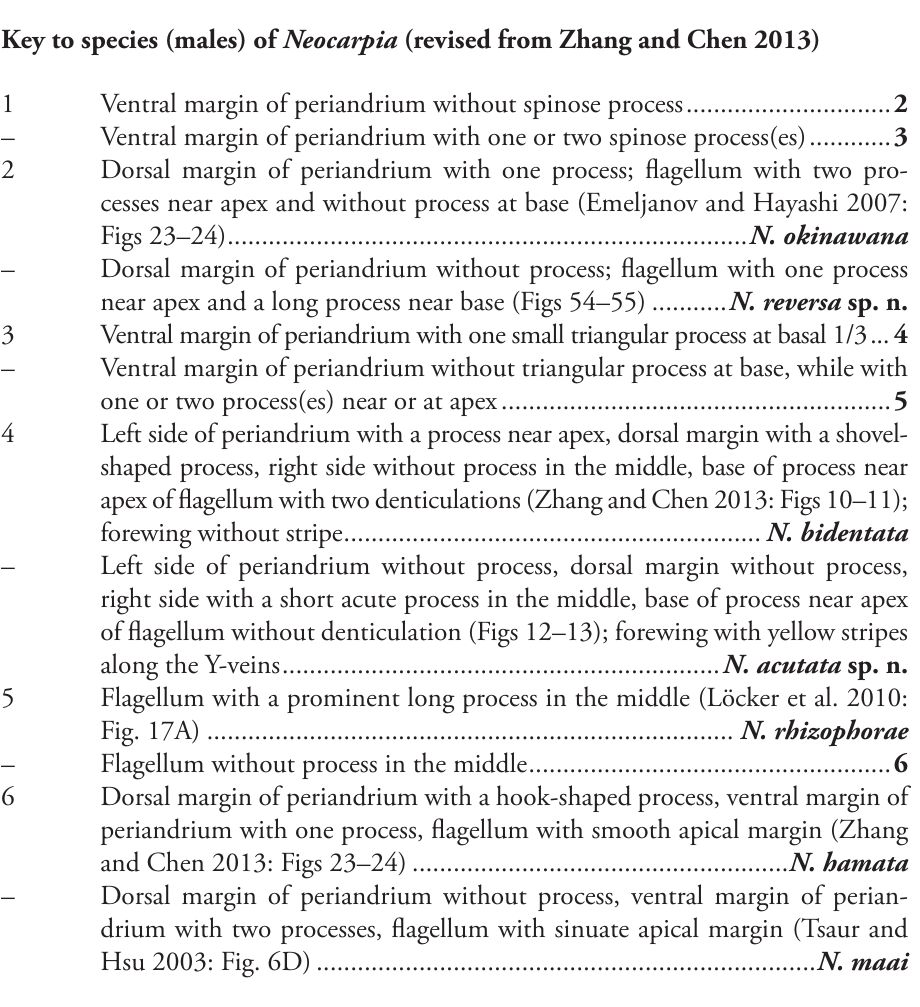
Key to Chinese species (females) of Neocarpia (except for N. maai ) 1 Posterior vagina without long longitudinal sclerite (Figs 41–42) .. N. hamata – Posterior vagina with a long longitudinal sclerite ......................................... 2 2 Long longitudinal sclerite on right side ventrally (Figs 65–66) ................... ........................................................................................... N. reversa sp. n. – Long longitudinal sclerite on left side ventrally ........................................... 3 3 Posterior vagina elongate, left side with two longitudinal sclerites; each side with a small sclerite near terminal in ventral view (Figs 23–24) ................... – Posterior vagina relatively short, left side with one longitudinal sclerite; pos- terior vagina with a wide sclerite medially and a small longitudinal sclerite on the left side near terminal in ventral view (Figs 32–33) ............ N.